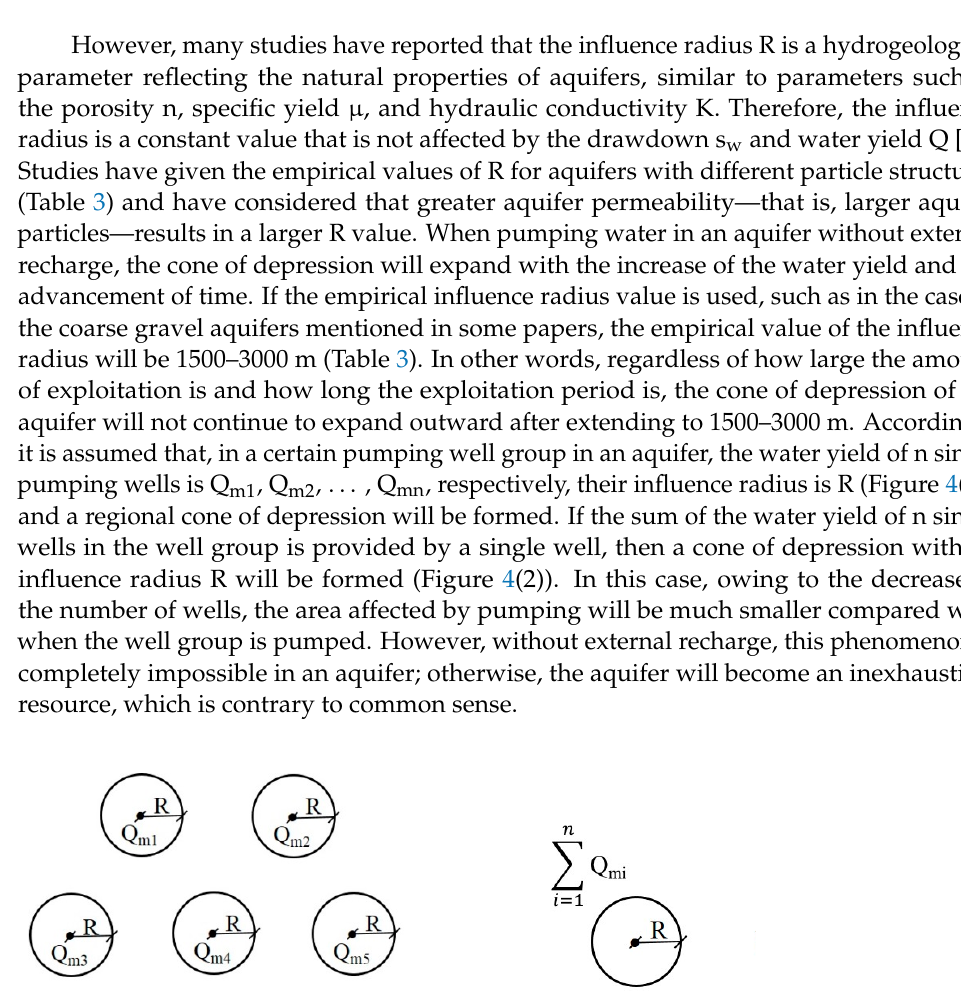
Figure 3. Influence radius of ripples in water and dominoes (used as an analogy to describe the in- fluence radius discussed in this paper). R is the influence radius, [L]; S is the distance in physics, [L]; and t is time, [T].